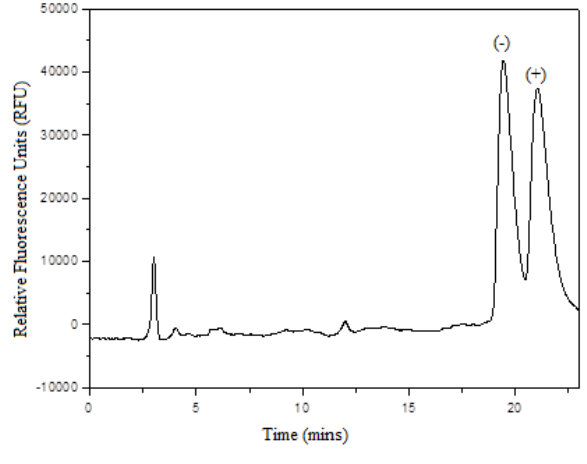
Figure 2: Final chiral method parameters for the separation of Alprenolol racemic mixture using fluorescence detection. Elution of (-)-Alprenolol and (+)-Alprenolol were seen at ~19 and 21 minutes